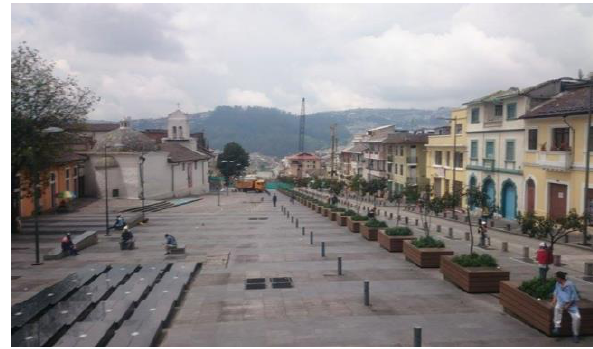
Figure 7. 24 de Mayo Boulevard realized above the Jerusalén ravine. Photo by Marianela Cruz.